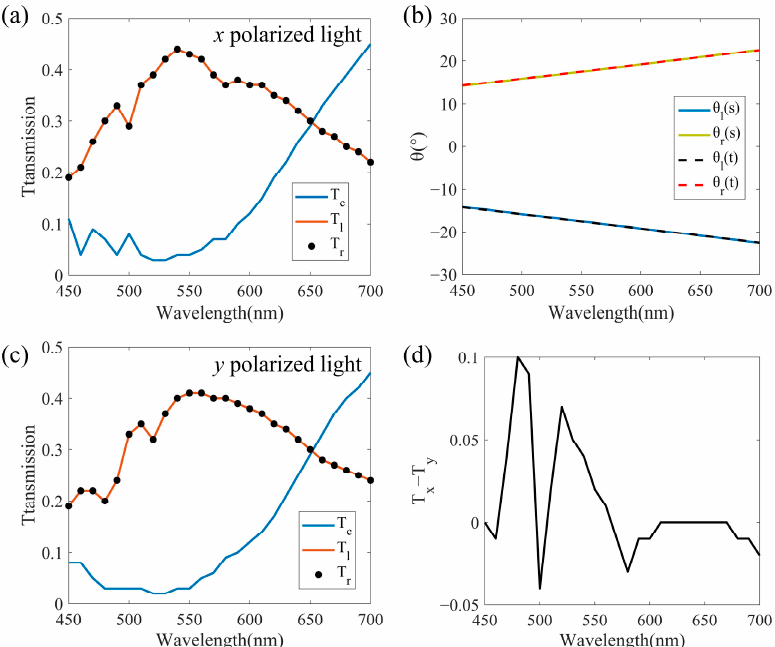
Figure 6. The results of verifying broadband characteristic and polarization insensitivity by the design of N l = N r = 5 in Section 3.1. ( a ) Transmittance spectrum of split leftward beam T l , split rightward beam T r , and vertical transmitted beam T c for x polarized light incidence. ( b ) The split angles obtained by simulation (solid line) and theoretical calculation (dashed line) at the corresponding wavelength. ( c ) Transmittance spectrum of T l , T r , and T c for y polarized light incidence. ( d ) The difference of T l or T r between the x and y polarized lights incidences.